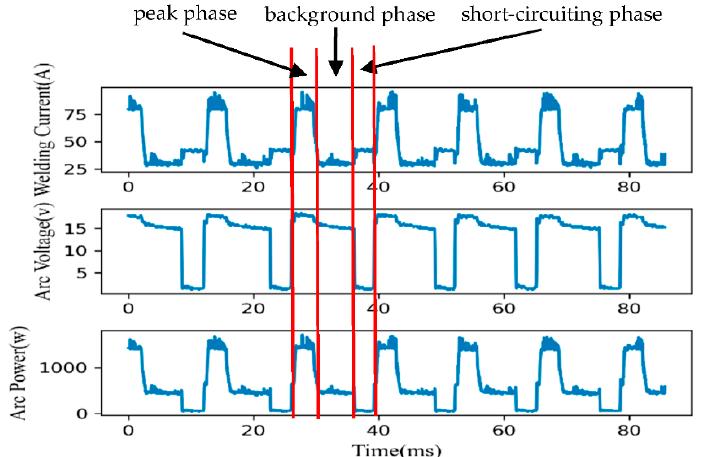
Figure 6. CMT cycle.